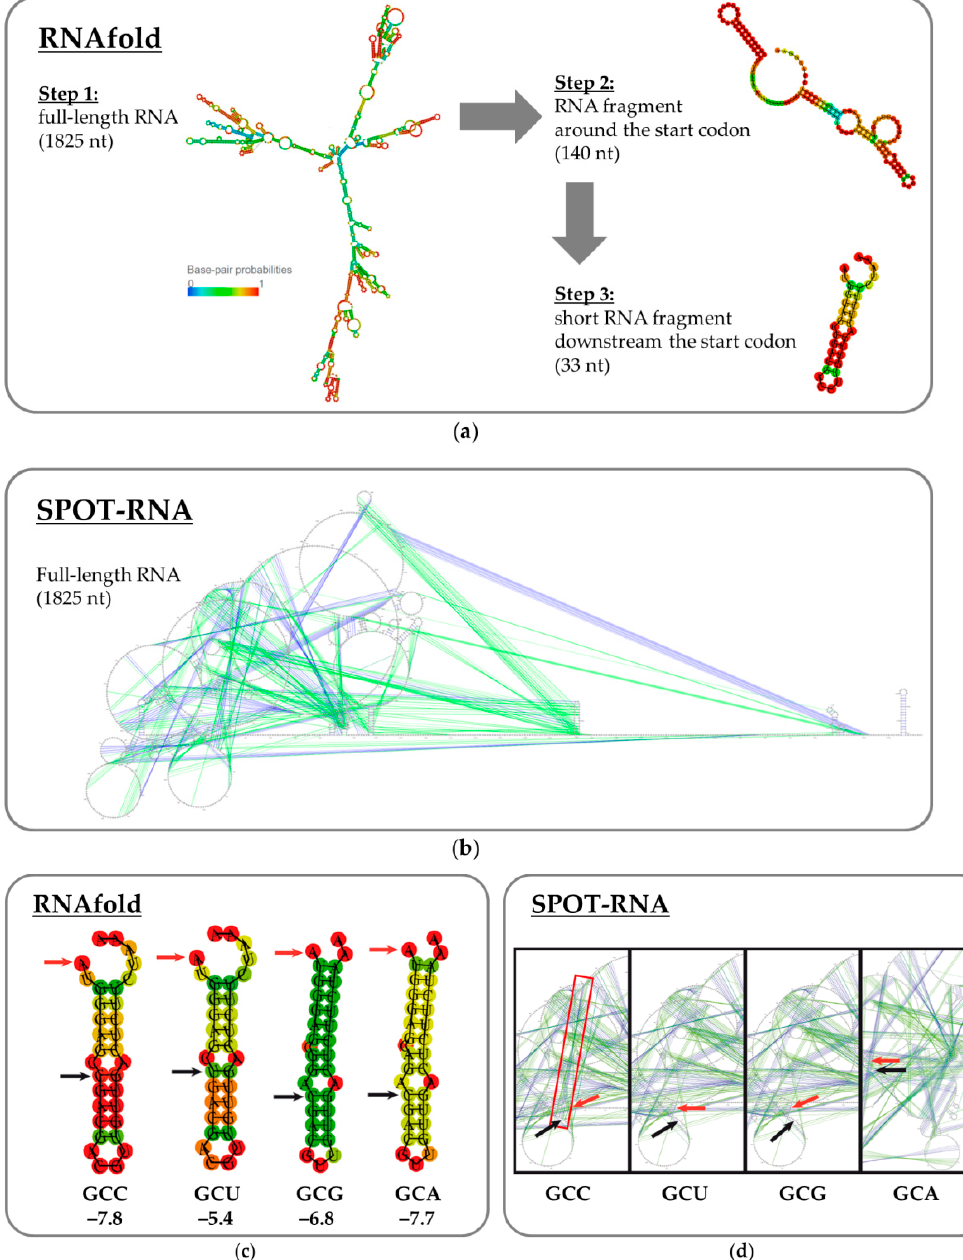
Figure 3. Effects of the point mutations on mRNA secondary structure predicted using the RNAfold and SPOT-RNA programs. ( a ) Selecting the mRNA fragment for the RNAfold analysis. The predicted probability of being paired or unpaired is color-coded from blue (zero probability) to red (100% probability). To see the RNAfold results for all full-length mRNA variants, please refer to Figure S1 in the Supplementary Materials. ( b ) The full-length mRNA structure predicted by SPOT-RNA (in a radial representation). The secondary structure is depicted with colored lines (blue for canonical base pairs and green for non-canonical lone pairs and triplets). ( c ) The optimal secondary structure of the hairpin in the beginning of the CRM197-encoding mRNA (33 bases) predicted by the RNAfold algorithm. Each red arrow indicates the first nucleotide of the start codon; each black arrow points to the mutant nucleotide. The variable nucleotide triplets are written near the corresponding hairpins. The minimum free energy values for the shown structures are given below in kcal/mol. The probability of hairpin formation is marked by color and increases from blue to red. ( d ) Long-range interactions in the CRM197-encoding mRNA predicted by the SPOT-RNA program. The GCC codon participates in such interactions (highlighted with a red rectangle), while the GCU and GCG codons do not. Each red arrow indicates the first nucleotide of